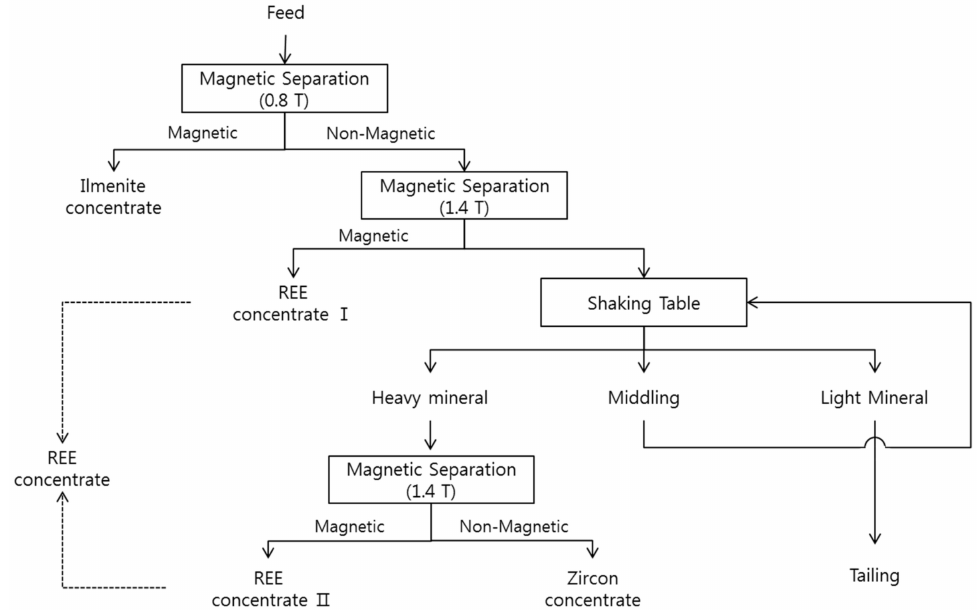
Figure 6. Flowchart of a batch test for rare earth element (REE) bearing placer